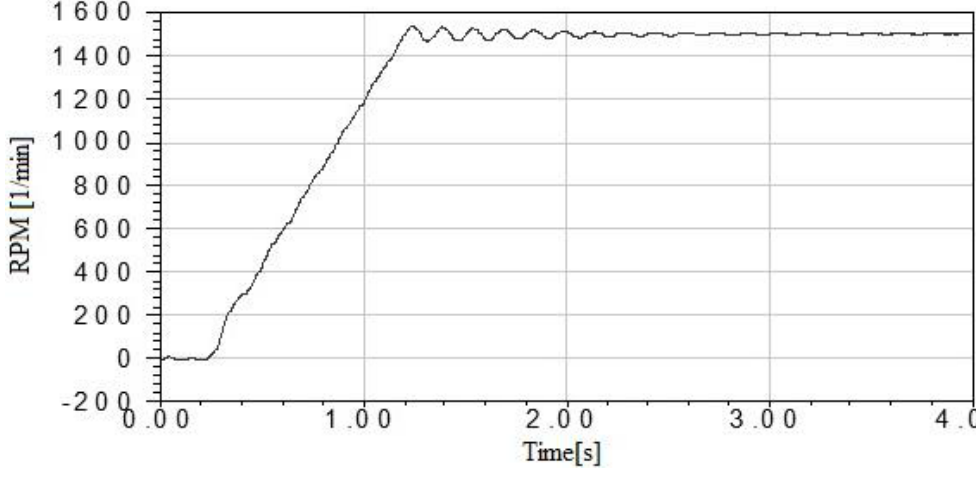
Figure 2. The characteristic of rotational speed during starting.